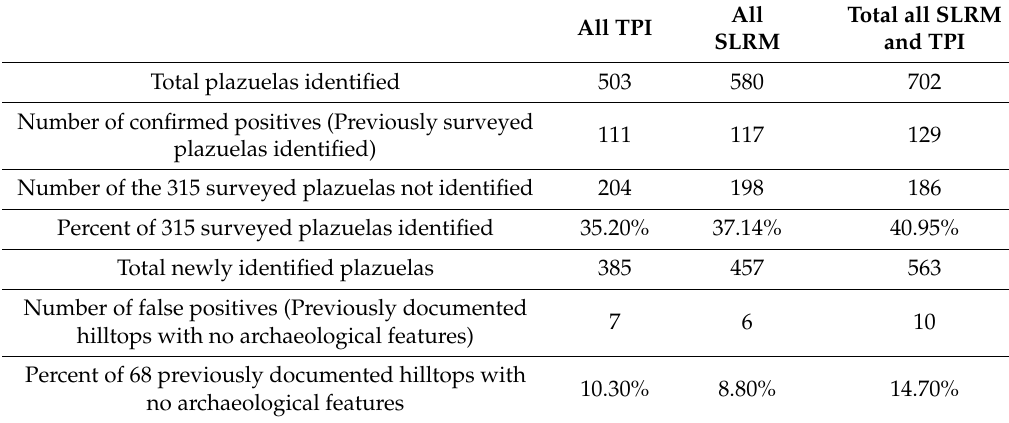
Figure 6. The location of plazuelas identified with both SLRM and TPI (green dots), only SLRM (blue dots), and only TPI (pink dots). The background is the TPI raster. Table 1. Comparison of plazuelas identified with SLRM and